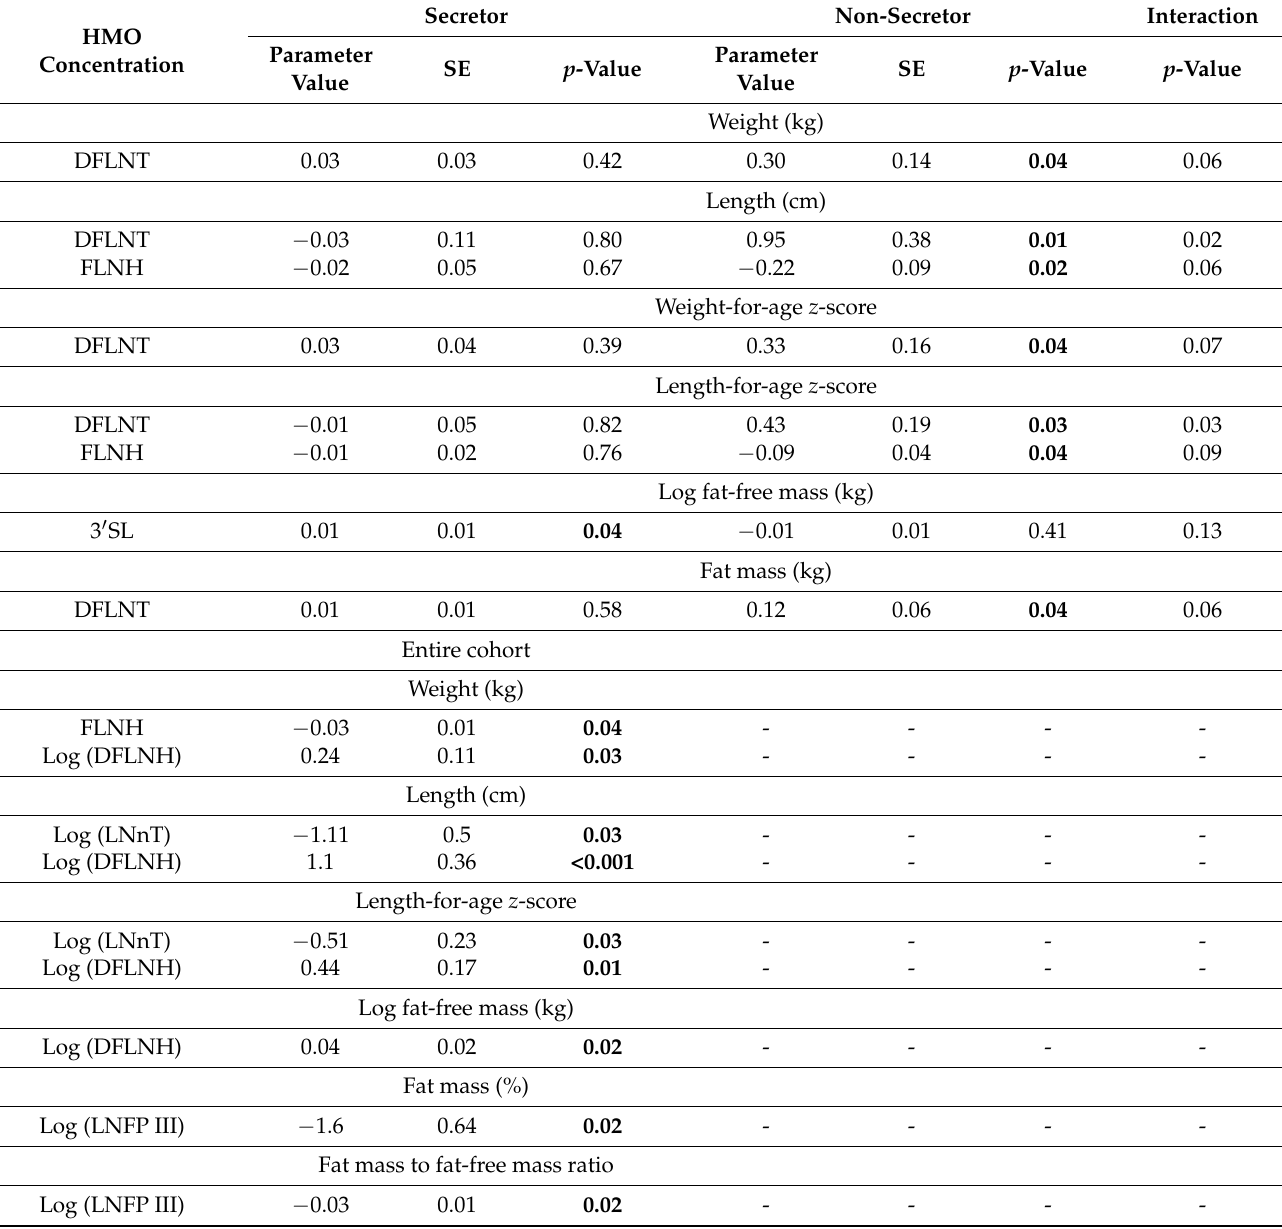
Table 6. Associations between HMO concentrations and infant body composition at three months